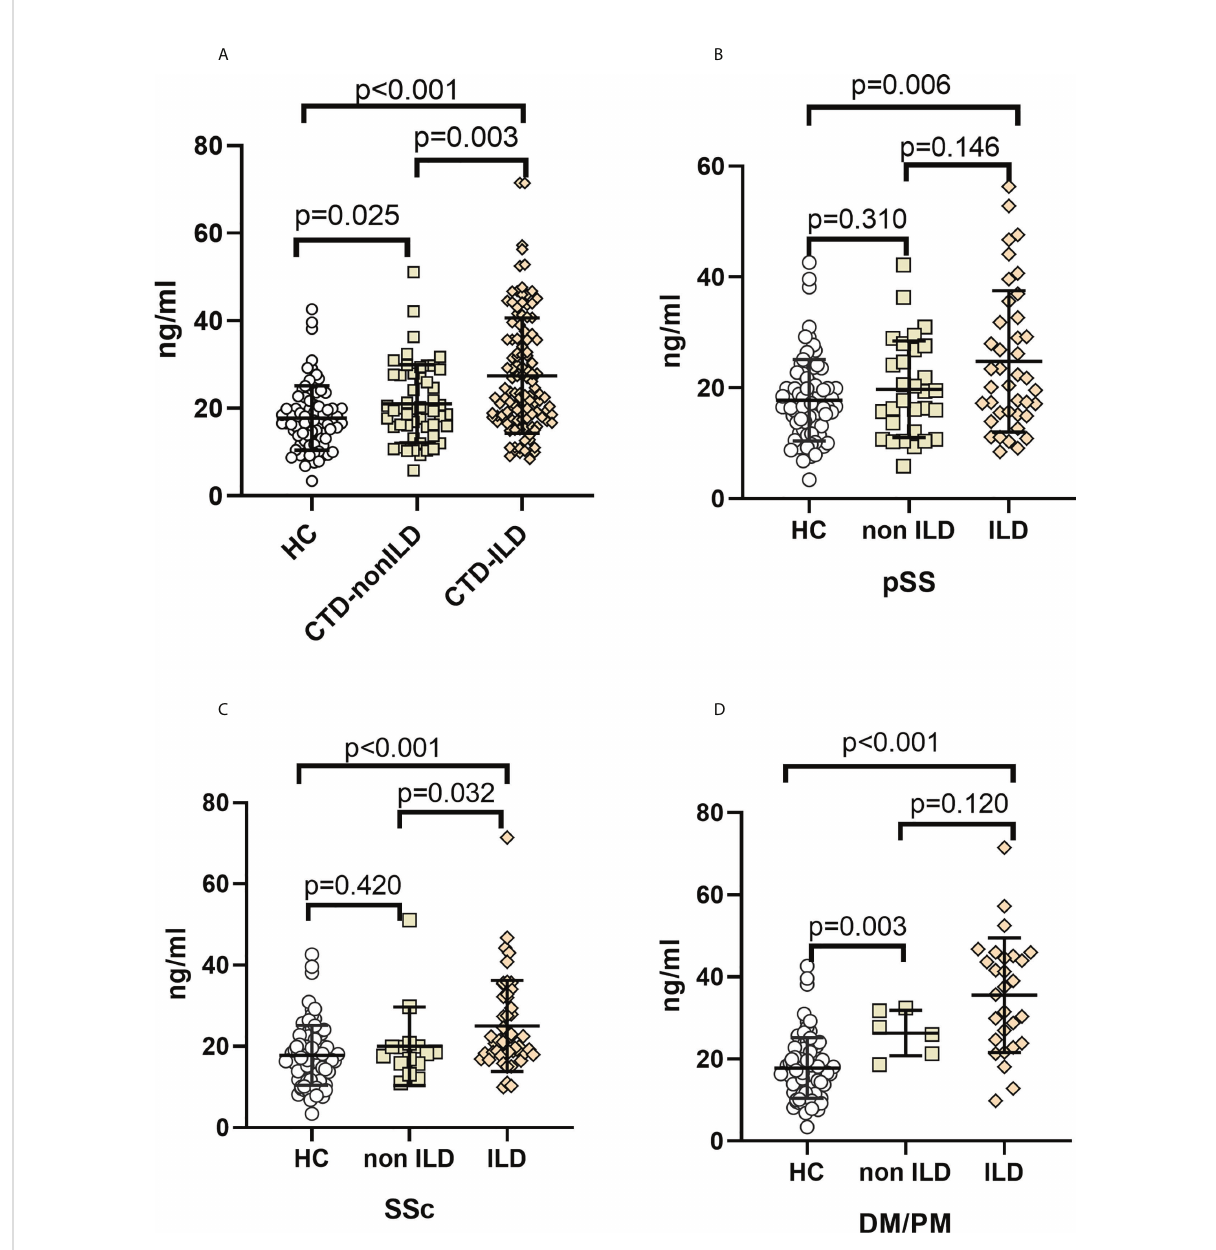
FIGURE 2 Elevation of MUC5B levels in CTD-ILDs (A) . CTD-ILD, CTD-non ILD, and healthy controls. (B). pSS-ILD, pSS-non ILD, and healthy controls. (C). SSc-ILD, SSc-non ILD, and healthy controls. (D). DM/PM-ILD, DM/PM-non ILD, and healthy control. The methodology used for these experiments was identical to those described in the legend for Figure